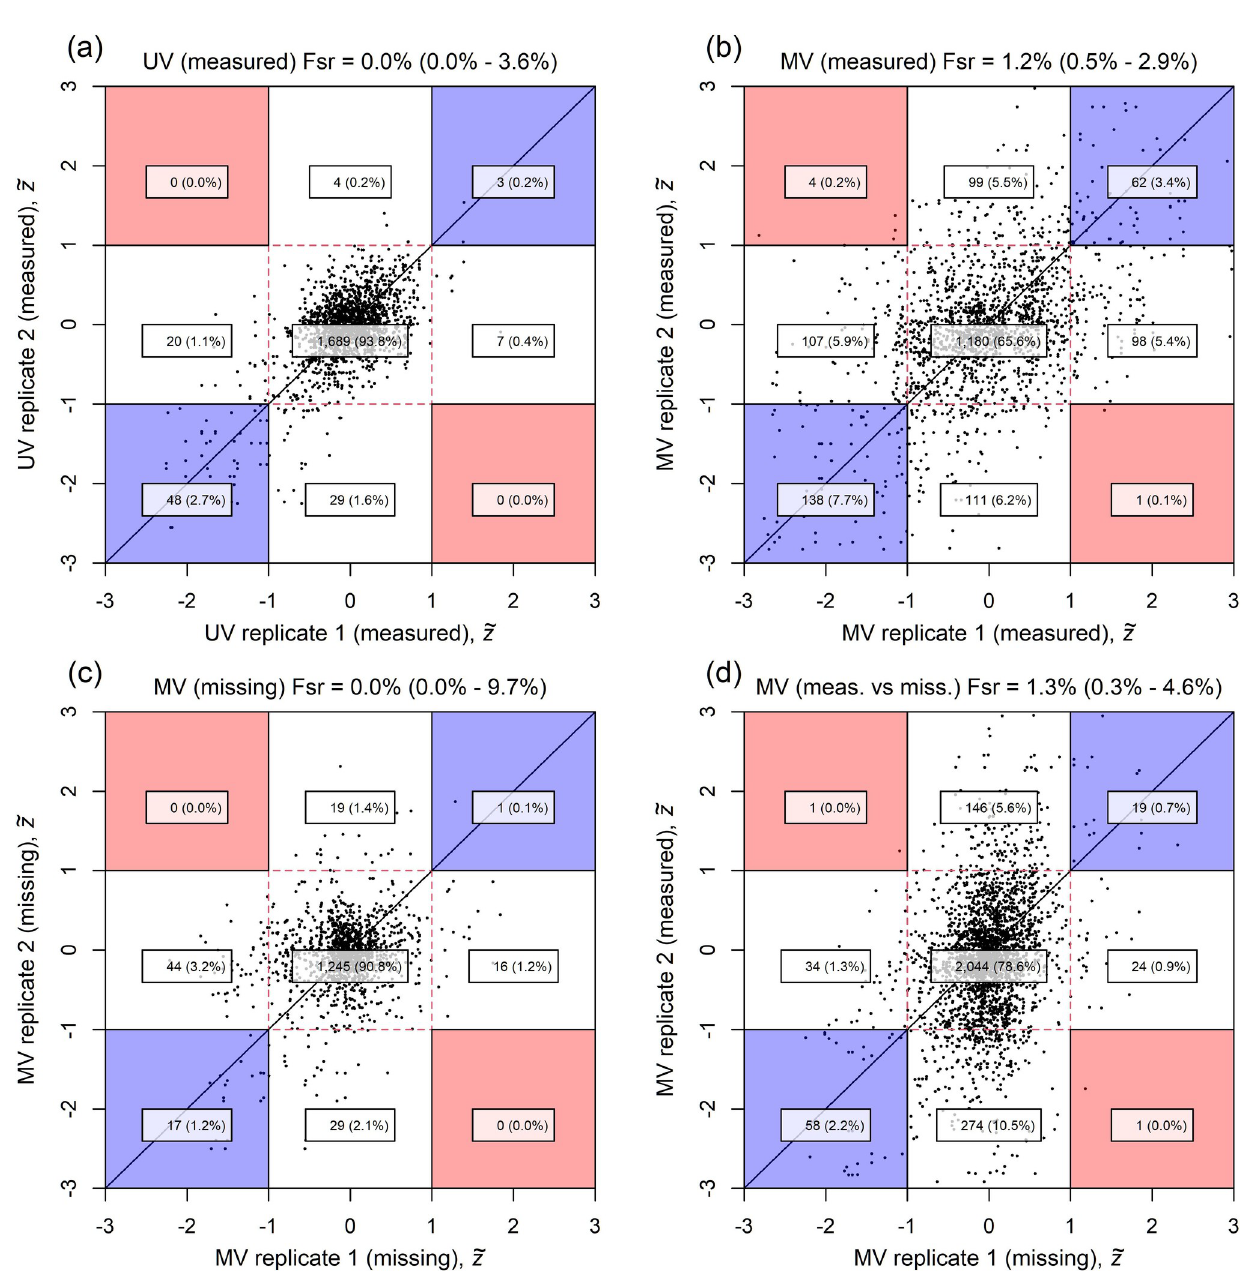
Fig 6. Replicability validation scatterplots comparing results across phenotyping laboratories. Each panel examines a different type of comparison of a pair of replication results: (a) UV model vs. UV model, (b) MV model (measured) vs. MV model (measured), (c) MV model (missing) vs. MV model (missing), (d) MV model (measured) vs. MV model (missing). We examine the interlaboratory agreement for the KO reference lines by scatterplotting scaled z -statistics, e z , for the same KO line but measured in different laboratories. Significant perturbations correspond to j e z j > 1 , as delimited on the graphs with dashed red lines. Each point in the plots corresponds to 2 different laboratories measuring the same phenotype on the same KO line. The most informative cases for estimating the false sign rate (Fsr) occur when both laboratories detect significant perturbations, which correspond to points lying in the blue/red shaded regions on the scatterplot. The laboratories agree in the blue shaded regions but disagree in the red shaded regions. c Fsr (95% CIs) are shown at the top of each panel and are based on the level of agreement/disagreement observed in the shaded regions (Methods– Replicability and false sign rates ). Counts (%) for each significance combination are superimposed; while the axes extend to [–3, 3], the counts apply to all data, including those beyond the plot’s scale. The data and code used to generate this figure are available at [13,14]. Fsr, false sign rate; KO, knockout; MV, multivariate; UV,